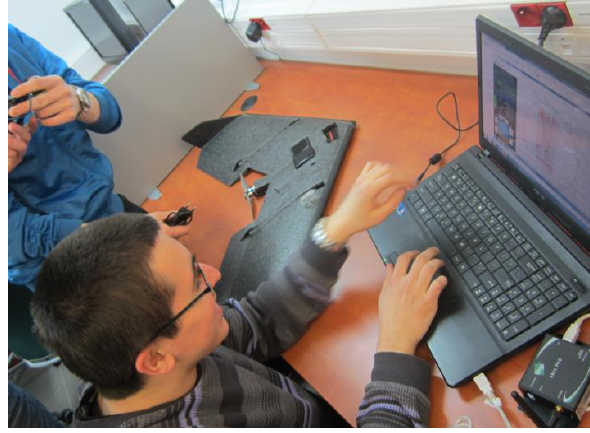
Figure 3. Process of generating automatic flight